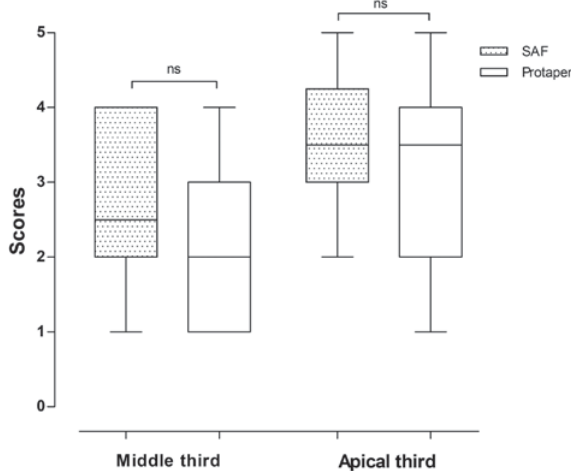
Figure 1- (cid:2) (cid:3)(cid:4)(cid:5)(cid:6)(cid:7)(cid:8)(cid:9)(cid:10)(cid:4)(cid:11)(cid:2) (cid:4)(cid:12)(cid:2) (cid:13)(cid:14)(cid:15)(cid:2) (cid:15)(cid:12)(cid:16)(cid:17)(cid:7)(cid:17)(cid:18)(cid:2) (cid:4)(cid:12)(cid:2) (cid:19)(cid:15)(cid:20)(cid:12)(cid:21)(cid:22)(cid:23)(cid:24)(cid:25)(cid:10)(cid:13)(cid:9)(cid:11)(cid:26)(cid:2) File (SAF) and ProTaper for removal of Ca(OH)